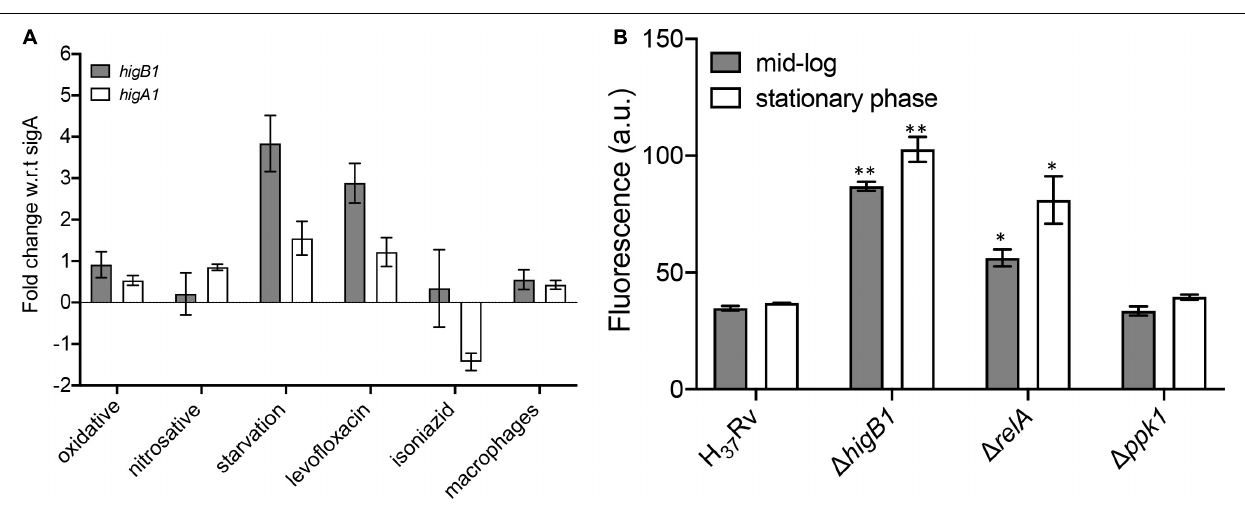
or (cid:49) relA or (cid:49) ppk 1 strains and fluorescence was determined